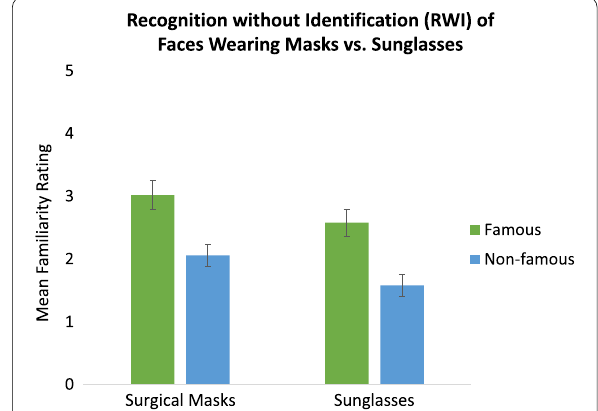
Fig. 3 The Face Recognition without Identification (RWI) effect— discriminability via higher familiarity ratings for unidentified occluded famous faces than occluded non‑famous faces—was comparable in magnitude when faces were unidentified from surgical masks versus from sunglasses. There was no significant main effect of occlusion‑type (masks vs